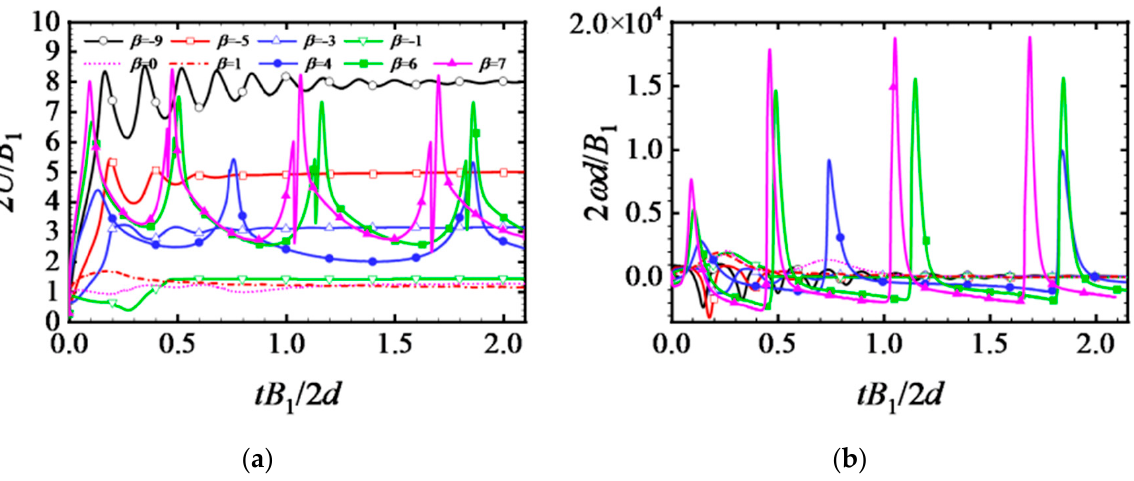
Figure 5. Variation in the velocity ( a ) and angular velocity ( b ) of rod-shaped squirmers with time for different values of β ( Re s = 0.1, s = d , i = 2).